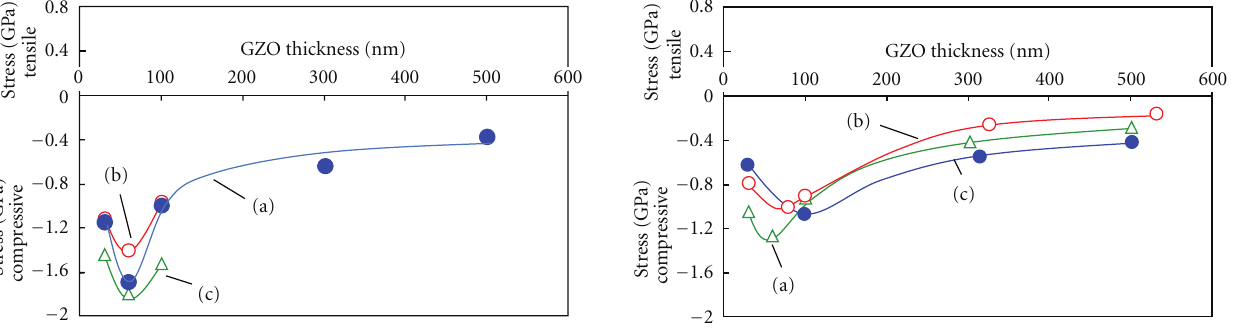
Figure 2: Dependence of residual stress in the GZO film formed by the RPD system on the film thickness before heat treatment. The symbols denote measured data. The dots (a) and open (b) circles correspond to the 1st and 2nd experimental series of GZO films respectively, and the triangles (c) show the residual stress in ZnO films without Ga (3rd series). The films in the 1st and 3rd series were formed on Si wafers with thermally oxidized silicon layer films.